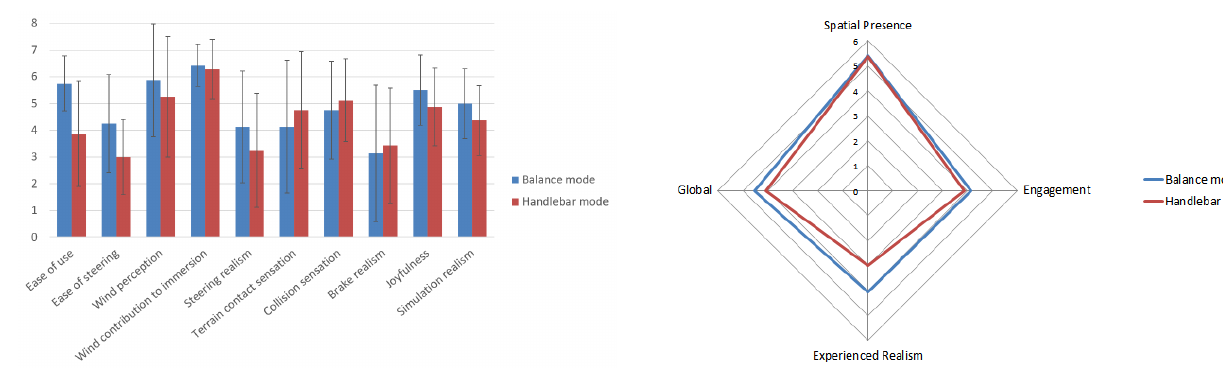
Figure 8. Averages values reported by participants after the first experiment through the SimBike-specific questionnaire. Participants using the Balance mode (blue bars) and participants using the Handlebar mode (red bars).